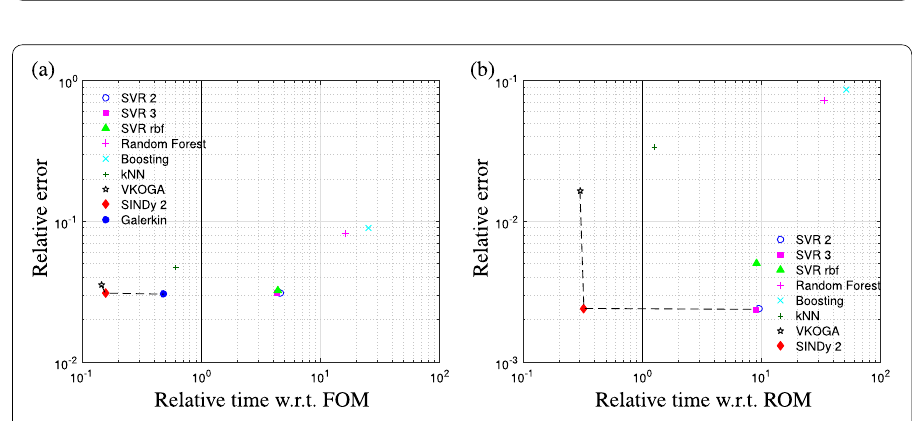
Fig. 4 Runge–Kutta for 1D inviscid Burgers’ equation: time evolution of relative error: a e FOM ( t ) in FOM; and b e ROM ( t ) in ROM